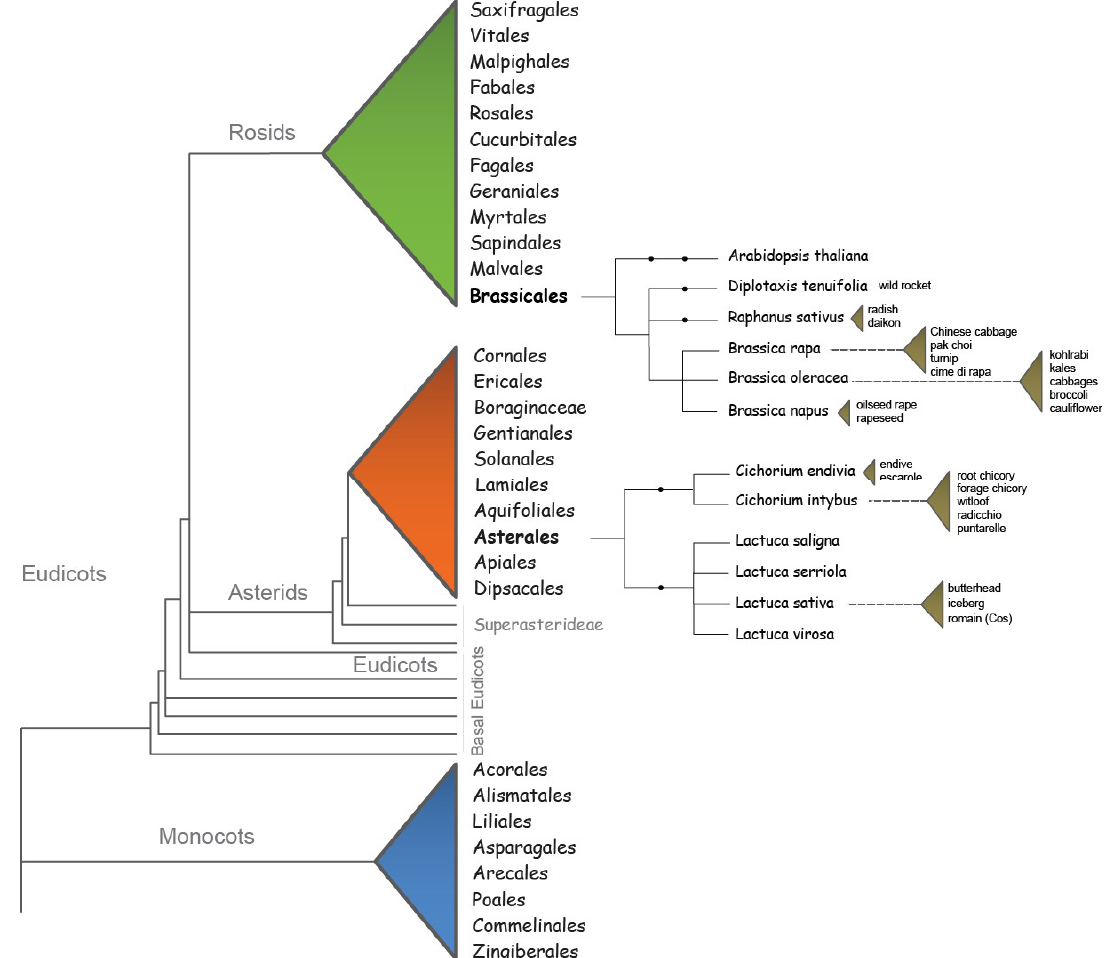
Figure 3. Schematic phylogenetic tree of eudicot and monocot species. Plant families are indicated for the main phylogenetic groups (http://science.kennesaw.edu/jmcneal7/plantsys/index.html). Phylogenetic relationships within Brassicaceae and Asteraceae species of interest were obtained using phyloT, a phylogenetic tree generator based on NCBI taxonomy (https://phylot.biobyte.de/). Cultivated crops for the different plant species are shown.